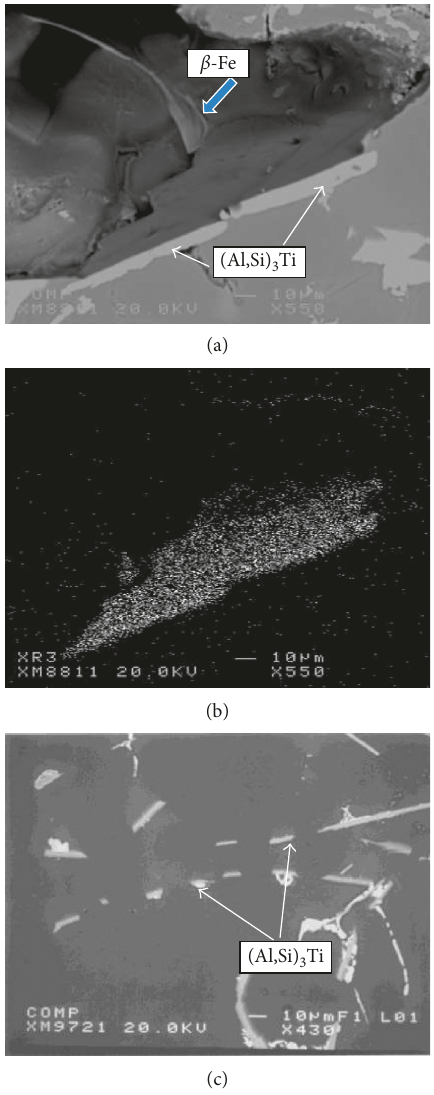
Figure 6: (a) Morphology of the new (Al,Si) (arrows) (melting temperature ∼ 950 ° C); (b) Ti distribution in (a); (c) white arrows in (a) and (c) indicate possible fragmentation of the (Al,Si) 3 Ti platelets.